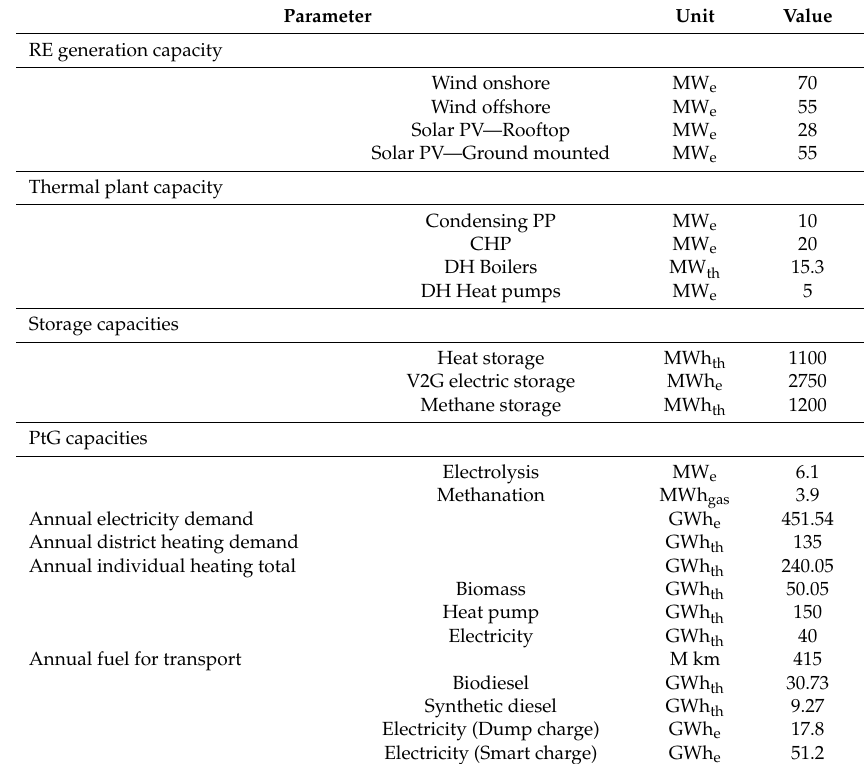
Table 1. Main input parameters for the 2030 SM El